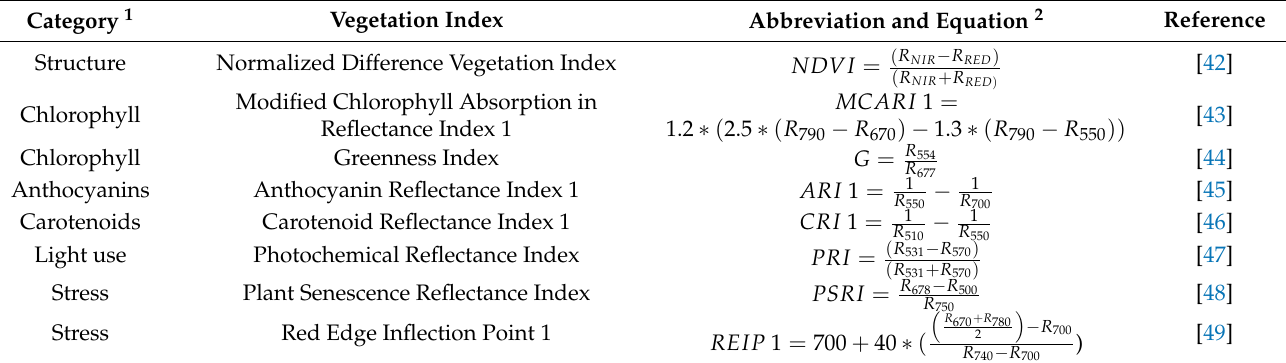
Figure 3. Shading quantification of no shade, partial shade and full shade for UV-A (W m − 2 ), UV-B (W m − 2 ) and PAR ( µ mol m − 2 s − 1 ) in absolute values including standard deviation and in relative measures to no shade conditions. Irradiation data can be found in the Supplementary Materials (Table S2, irradiation data). Table 1. Hyperspectral vegetation indices of leaf-based plant phenotyping used in this study, including equations and references. Category